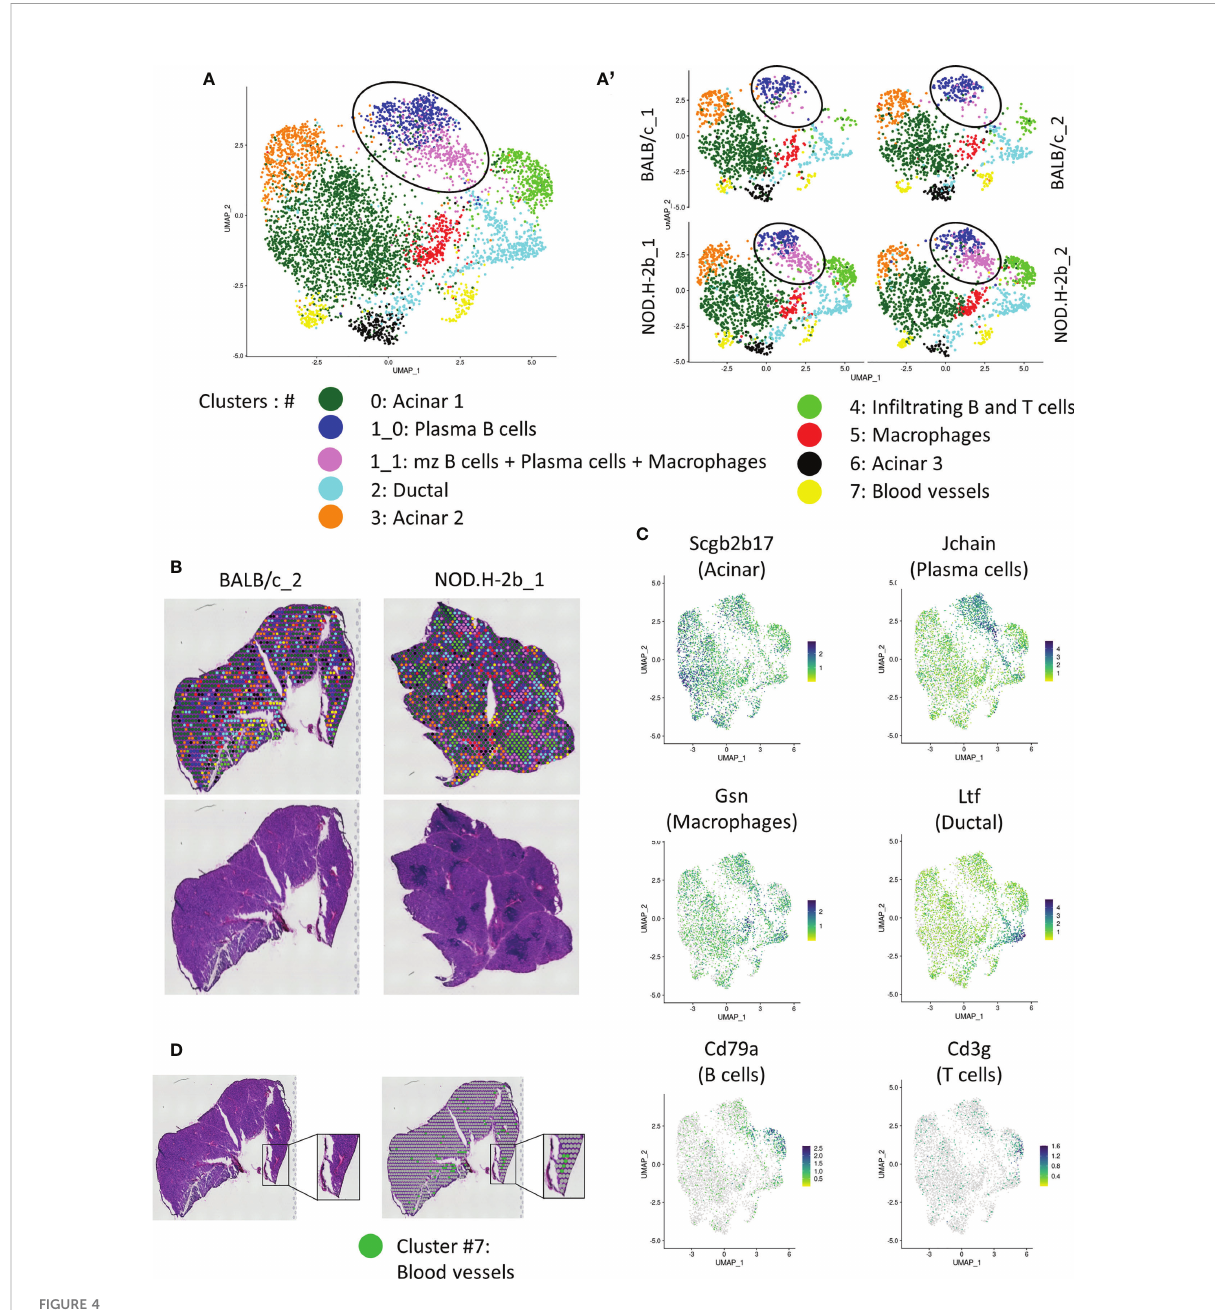
FIGURE 4 Spatial transcriptomic analysis of LG section from NOD.B10 and BALB/c mice. (A) UMAP of integrated samples (2 BALB/c and 2 NOD.H-2B) from 10 m m LG cryosections. (A ’ ) UMAPs split by samples showing that all clusters are represent in each sample. (B) H&E staining of the sections sequenced with spatial localization of the spot colored depending on their clusters. (C) Features plot of speci fi c markers de fi ning major clusters: Scgb2b17 (Acinar, Cluster 0, 3 and 6), Jchain (Plasma cells, cluster 1), Cd79a (B cells, cluster 4), Cd3g (T cells, cluster 4), Gsn (Macrophages, cluster 5) and Ltf (Ductal, cluster 2). (D) Colocalization of spot from cluster 7 (Erythroid cells) with blood